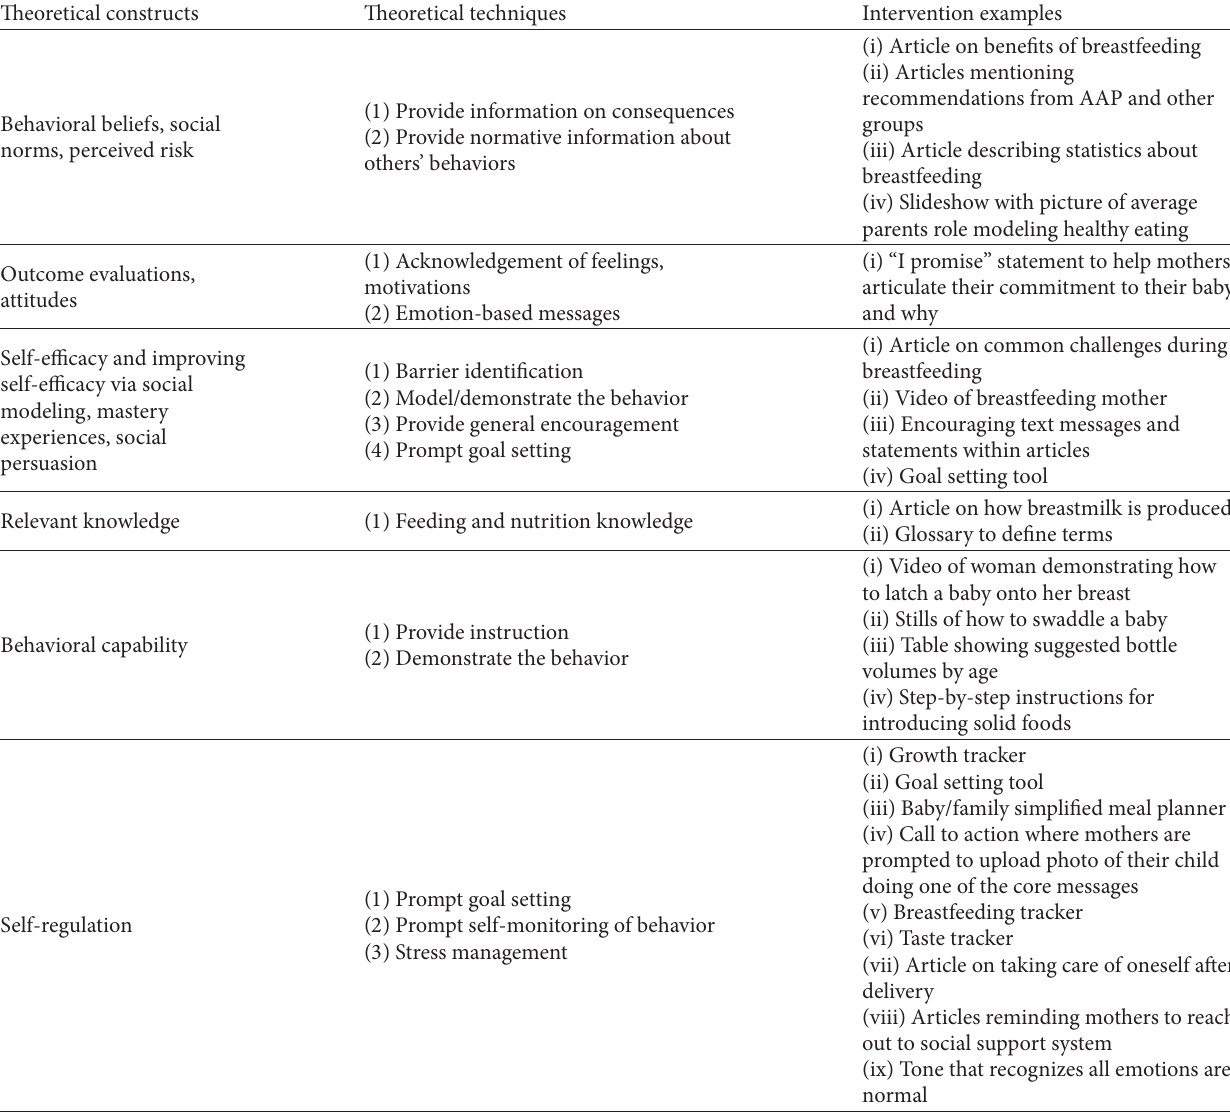
Table 2: Examples of intervention features for behavioral